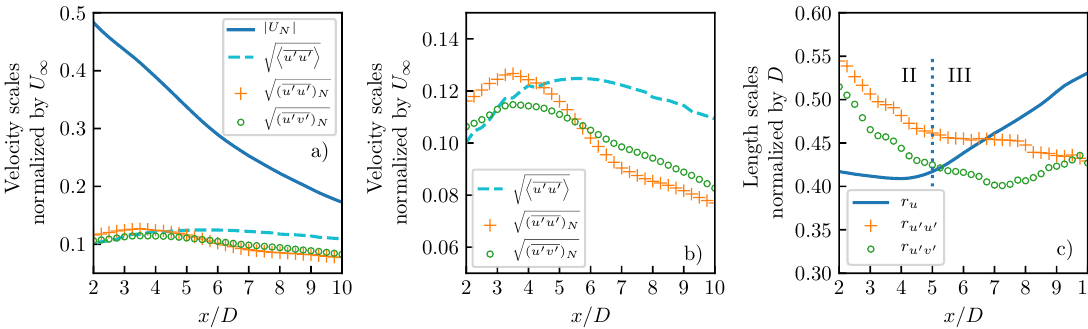
Figure 14. The comparison of the characteristic scales. Four velocity-like scales are shown in ( a ), three of which are shown in ( b ) as an enlarged view. The length scales are shown in ( c ). The scales for the U ∞ , Reynolds stress components u (cid:48) u (cid:48) , and u (cid:48) v (cid:48) are denoted by —, +, and mean velocity deficit U − respectively. The square root of the spanwise mean of the Reynolds stress u (cid:48) u (cid:48) is denoted by